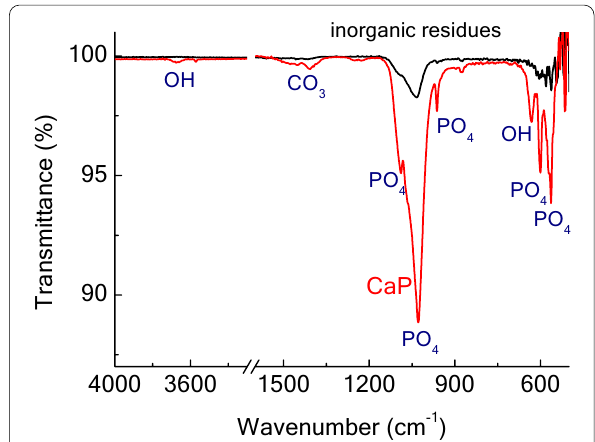
Fig. 5 FTIR of the inorganic residues (i.e., non-calcined powder) and of the calcined CaP sample